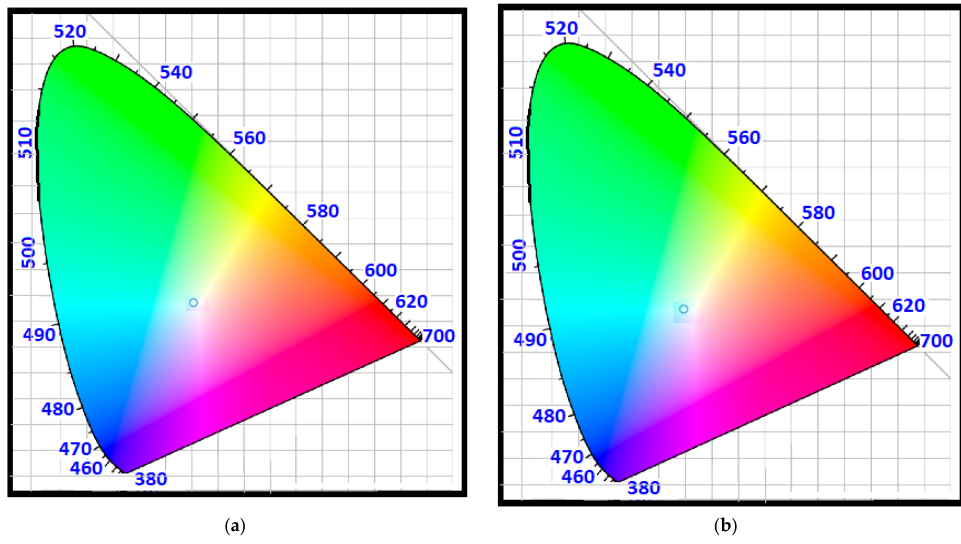
Figure 15. CIE 1931 representations for ( a ) white LED from Figure 1 and ( b ) proposed SiO 2 /Si nano- particle with R = 85 nm.